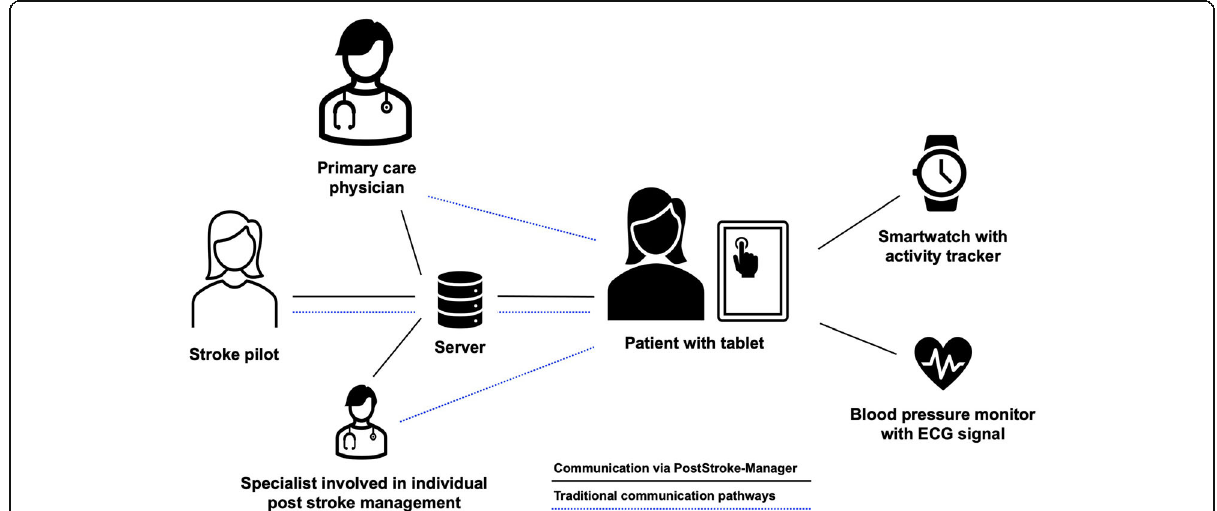
Fig. 2 Conceptualization of the PostStroke-Manager with a central position of the patient, equipped with a tablet and mobile devices for registration of physical activity, blood pressure, and electrocardiographic signals. Using WLAN or SIM cards, the tablet will be connected to a server allowing interactions with the primary care physician, the stroke pilot as well as specialists if indicated. Thereby, the system will mimic traditional communication pathways and at the same time will add a lot of technological advances for post stroke management. Abbreviation: ECG: electrocardiography. The figure including icons was created with Microsoft PowerPoint and Word for Mac (version 16.47, 2021, Microsoft, Redmond,